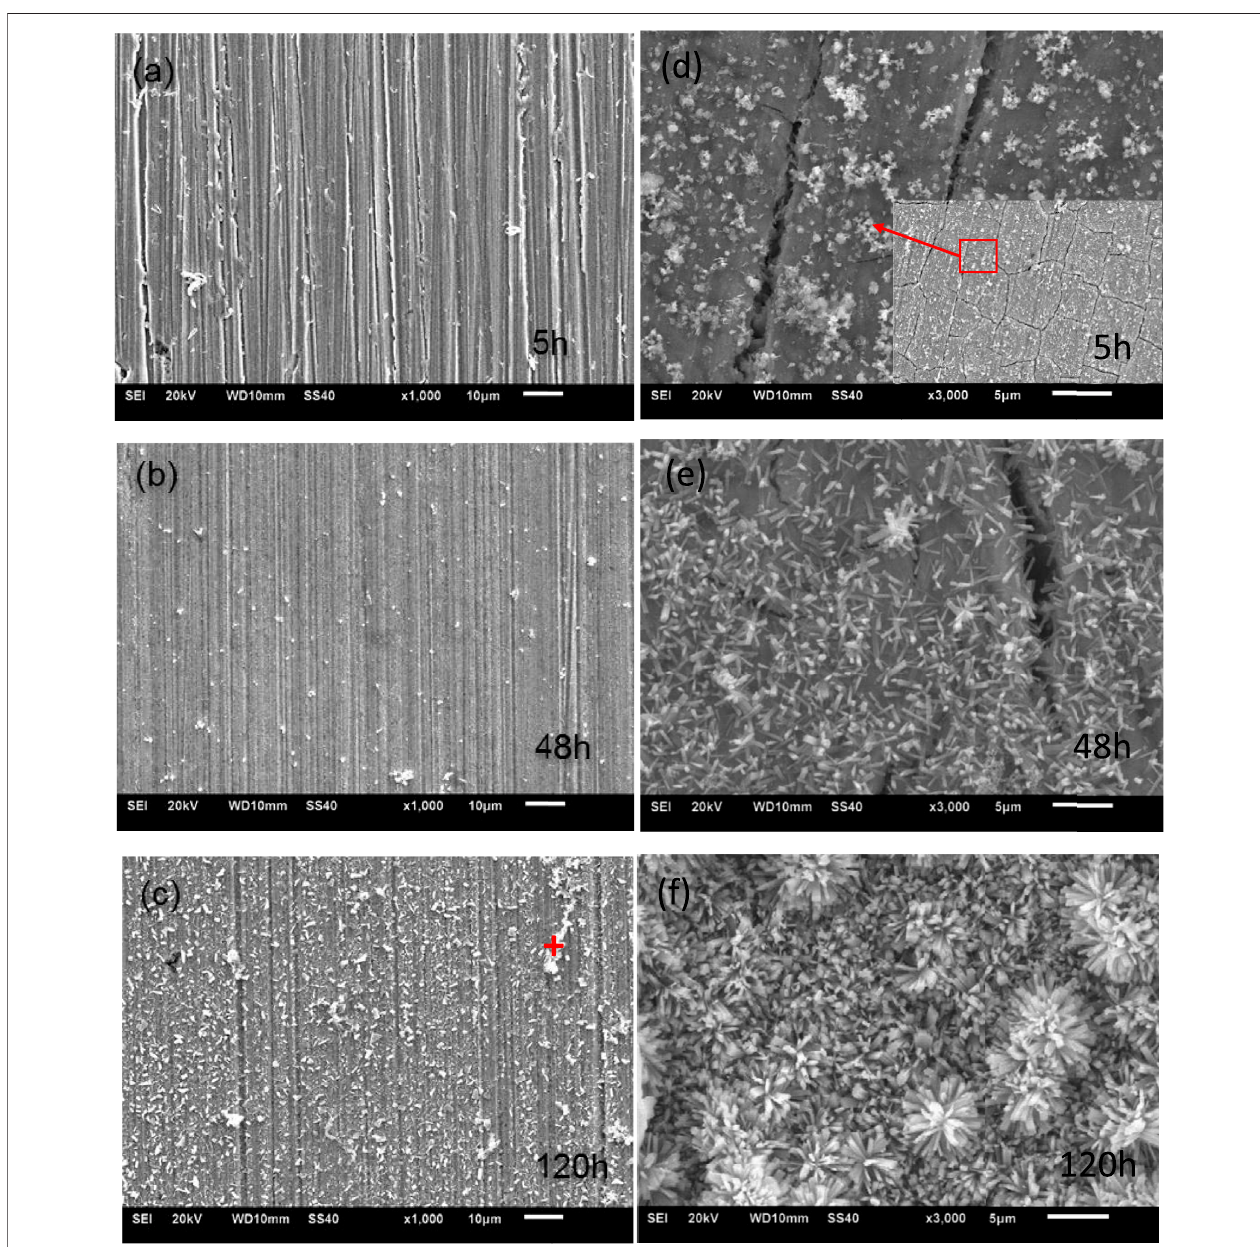
FIGURE 3 | SEM morphology of the corrosion products formed on S13Cr SS exposed to the 180 ° C formate fl uid with (A – C) N 2 and (D – F) CO 2 saturated.